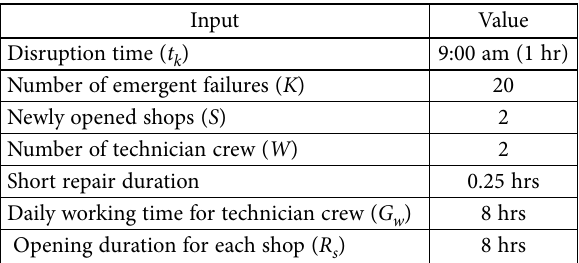
Table 2. Parameters of Model I